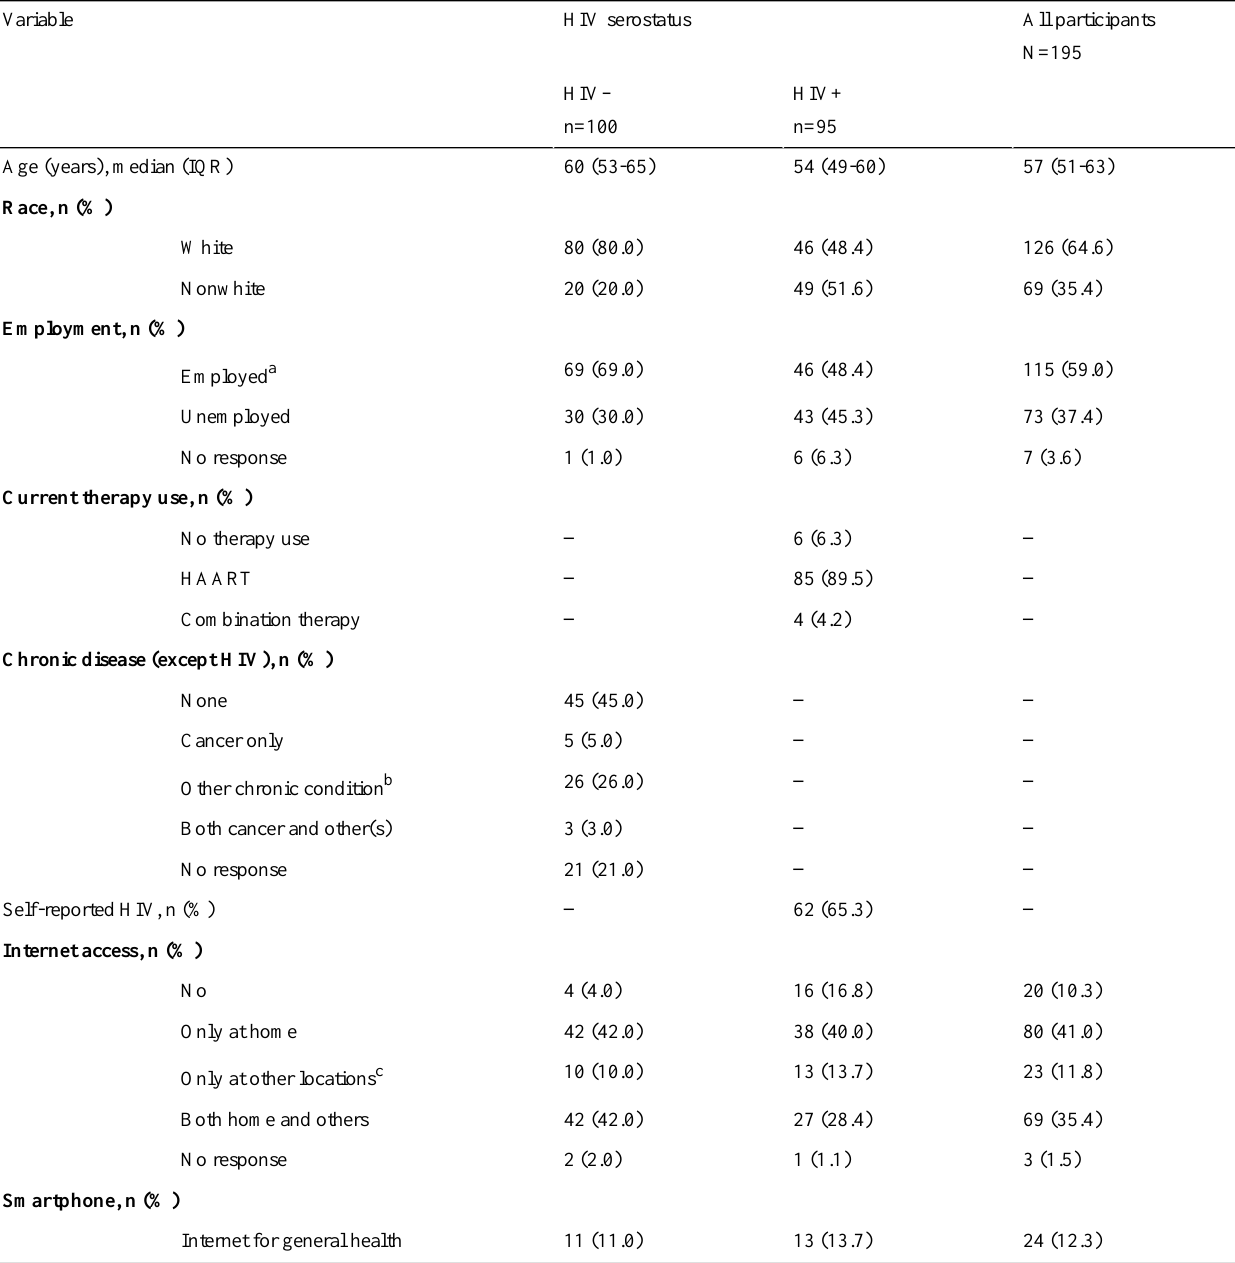
Table 1. Demographics, health condition, and Internet access of the participants in the study.